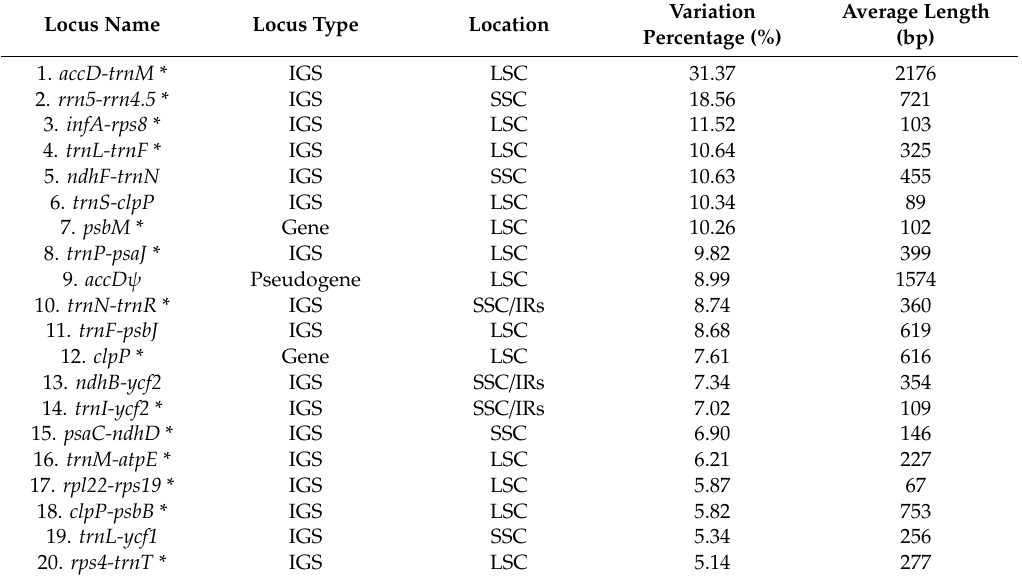
Table 3. Percentage of variation and length of the 20 most variable chloroplast loci recorded in the seven Mammillaria species. The type of locus (gene, pseudogene or IGS) and the structural region of the genome where it is located are shown. SSC / IRs indicates that the locus is in the SSC region in all the species, except M. zephyranthoides , which has it in IRs. * indicates the 14 loci that were used to obtain the phylogenetic relationships of the seven studied species. The last column represents the average length (bp) in the seven